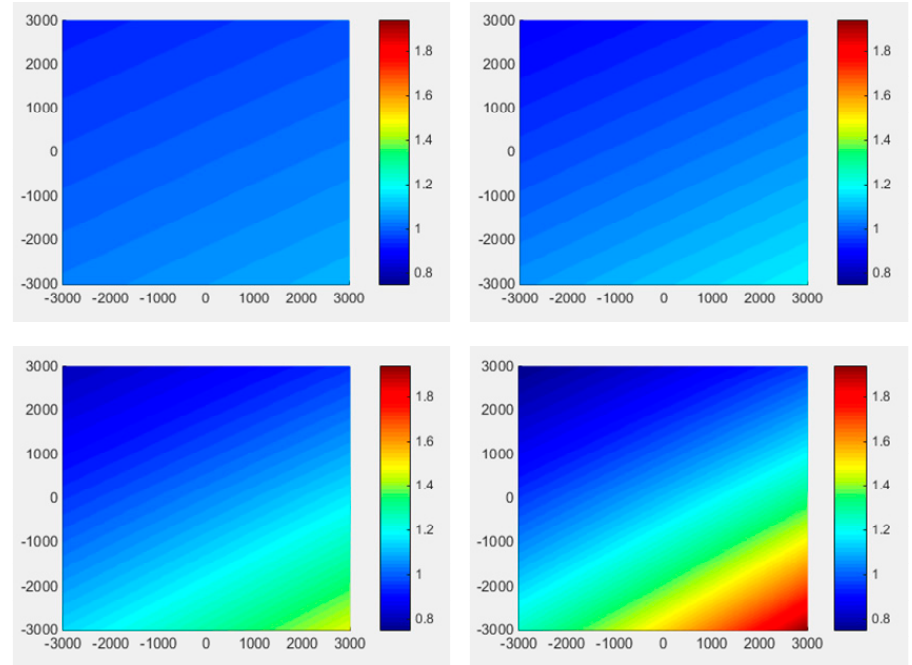
Figure 2. Distribution of GSD ( X m , n ) of an image with different ω and ϕ angles. ( a ) ω and ϕ angles are Figure 2. Distribution of GSD ( (cid:1850) (cid:3040),(cid:3041) ) of an image with different (cid:2033) and (cid:2030) angles. ( a ) (cid:2033) and (cid:2030) angles are Figure 2. Distribution of GSD ( (cid:1850) (cid:3040),(cid:3041) ) of an image with different (cid:2033) and (cid:2030) angles. ( a ) (cid:2033) and (cid:2030) angles are 3 ˝ ; ( b ) 5 ˝ ; ( c ) 10 ˝ ; ( d ) 15 ˝ . 3°; ( b ) 5°; ( c ) 10°; ( d ) 15°. 3°; ( b ) 5°; ( c ) 10°; ( d ) 15°.